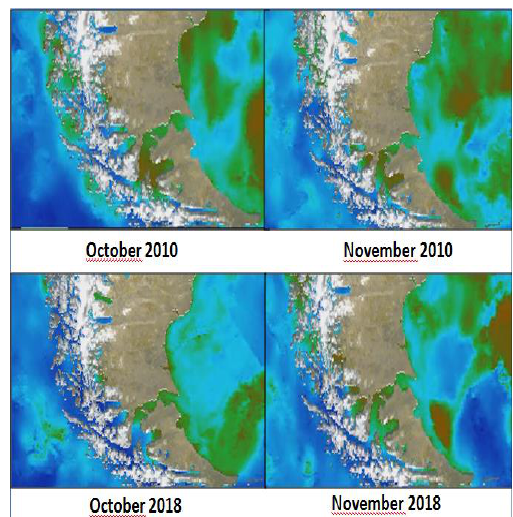
Fig. 3. Surface spatial distribution of Chlorophyll a along Magellan Strait in the spring of 2010 (CIMAR 16) and 2018 (modified of http://hermes.acri.fr/). Spatial analysis of Chlorophyll a during spring 2019 in the Magellan Strait and around showed that a concentration of 3 mg m -3 is common around Dawson Island. Similar situation was observed during spring 2010 and 2018 (Fig. 4).